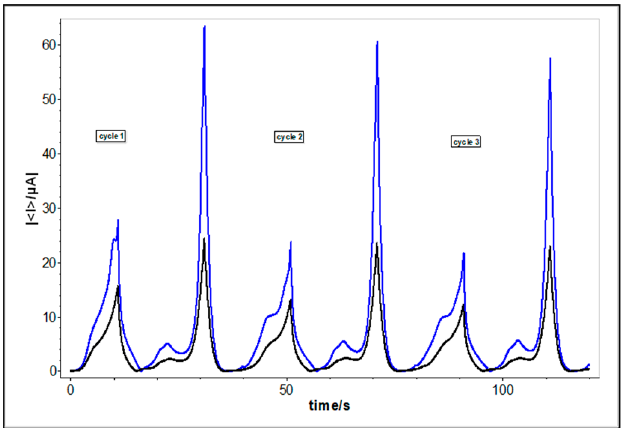
Figure 6. Evolution of current vs time in cyclic voltammograms recorded for basil methanolic extracts of AB (blue) and MB (black), E = ±1 V/Ag/Ag Cl sat , at 100 mVs − 1 ; 3 cycles.